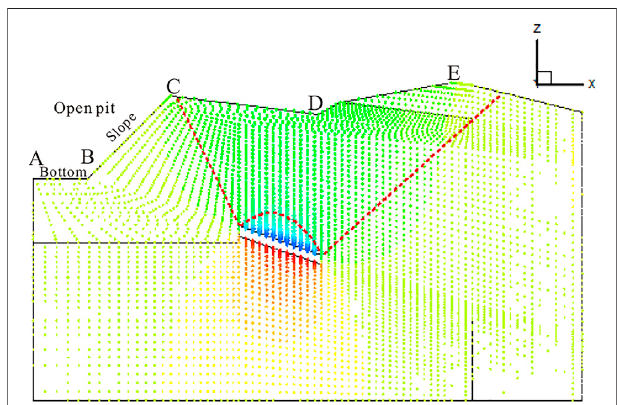
FIGURE 12 | Vector graph of vertical displacements of the overburden and surface during room and pillar mining.